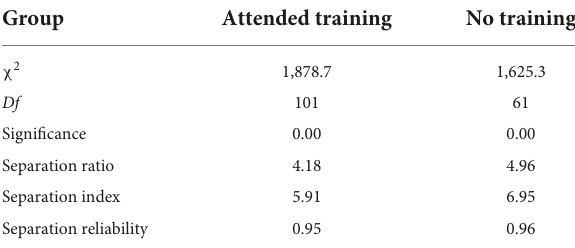
TABLE 9 Rater facet report based on training experience.